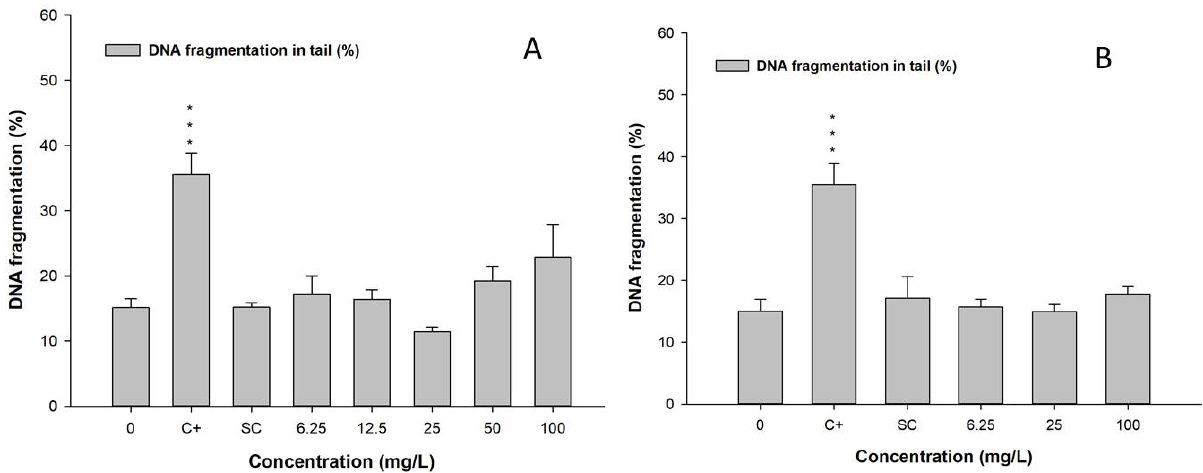
Figure 4 – Comet assay, A - exposure test, B – post-exposure test, C+ positive control, SC – solvent control (DMSO). No DNA fragmentation induction occurred in both cases (P>0.05). DNA fragmentation was observed in C+ group (**<0.01 and ***<0.001) when compared with control.